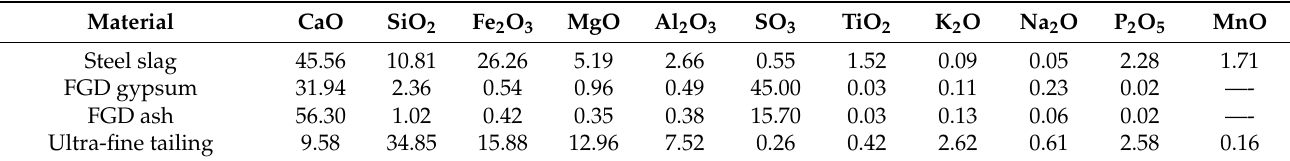
Table 4. Chemical compositions of raw materials (mass fraction/%).